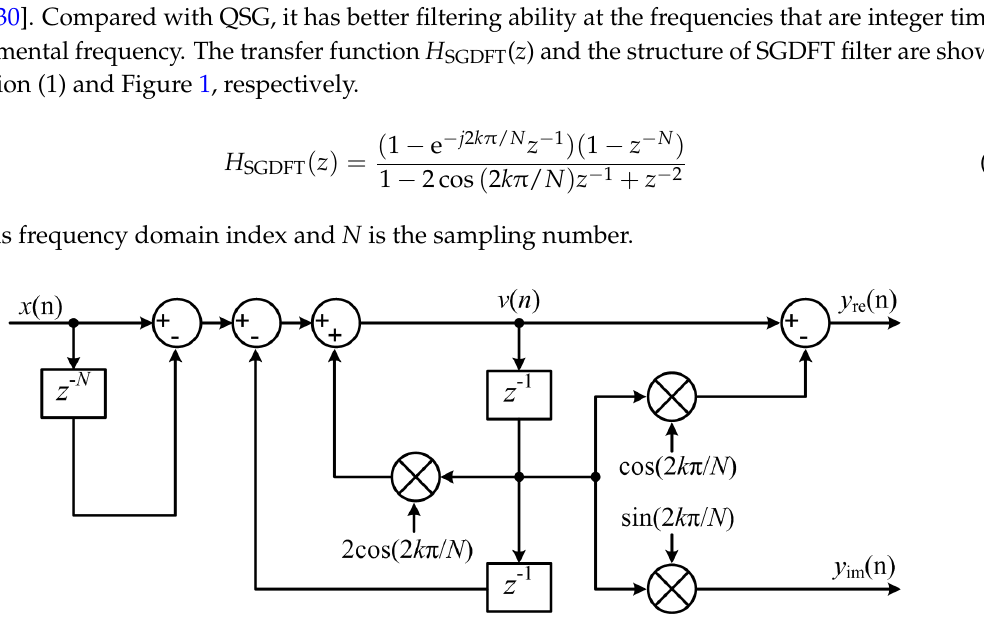
Figure 1. Block diagram description of SGDFT.